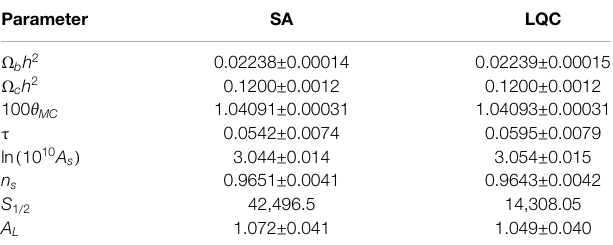
TABLE 1 | Comparison between the Standard Ansatz (SA) and LQC. The mean values of marginalized probability distributions for the six cosmological parameters, and values of S 1 / 2 calculated using C TT ℓ